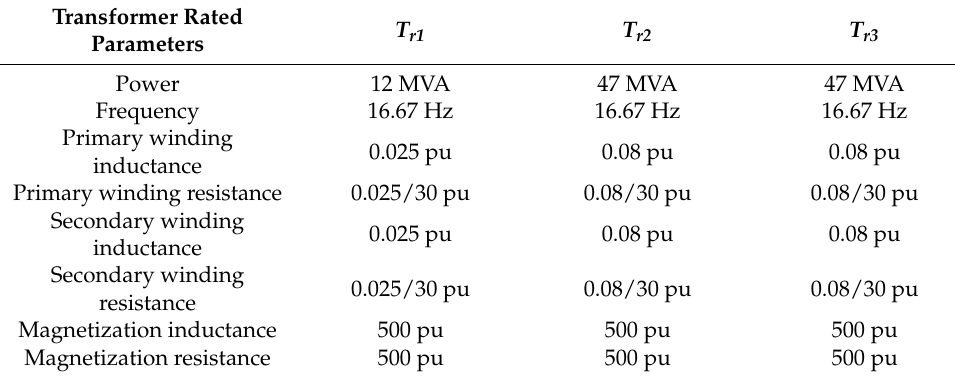
Table 2. Transformer parameters.